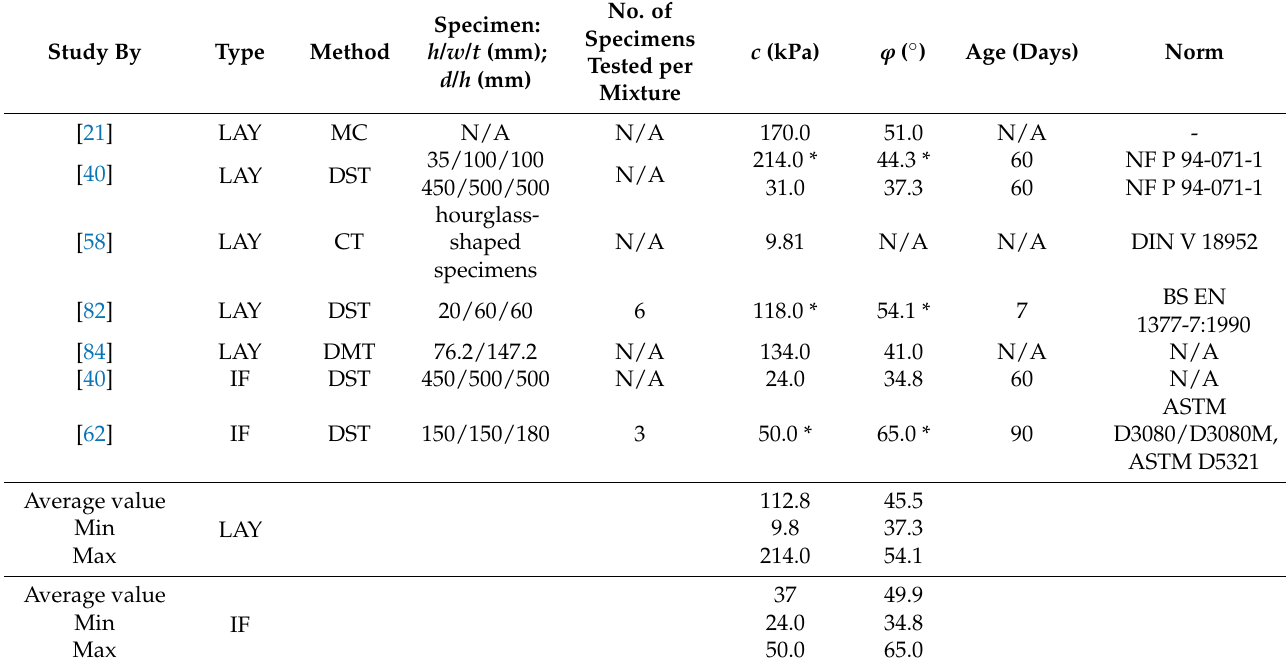
Table 7. Cohesion and friction angle values of the RE layer (LAY) and interface (IF) obtained at different age, with description of methods, specimens, and norms